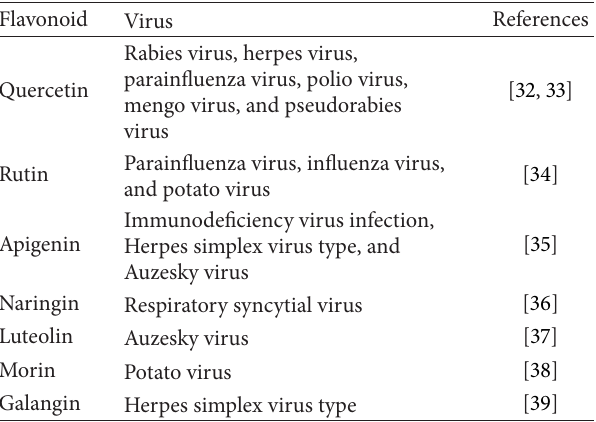
Table 4: Antiviral activity of various